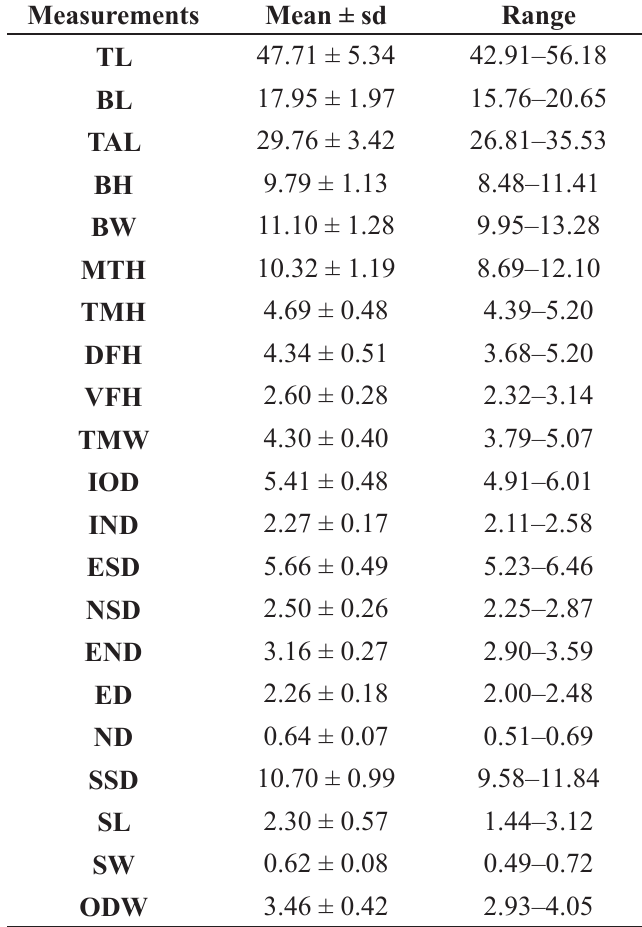
Table 2. Tadpole measurements of Odontophrynus toledoi sp. nov. between Gosner stages 37 and 40 (n = 7). Data are in millimeters and presented as mean ± sd. *sd = standard deviation. For abbreviations see material and